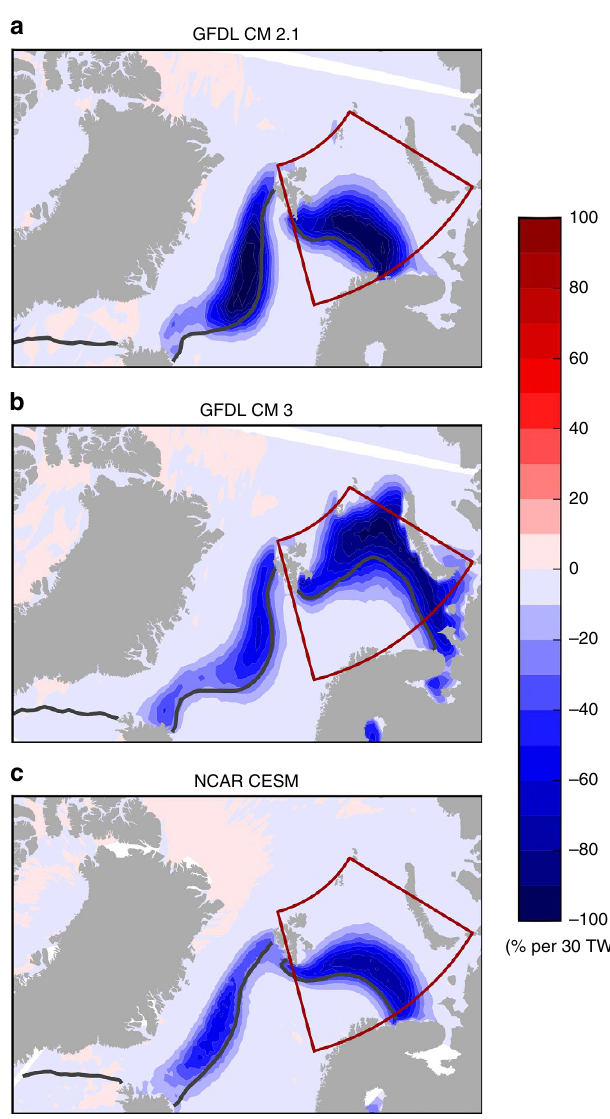
Figure 5 | Regression of 37-year March SIC trends on 37-year HT BSO trends in three long control simulations. ( a ) GFDL CM2.1 ( b ) GFDL CM3 ( c ) NCAR CESM. Red boxes outline the Barents Sea region, and black lines denote the climatological March sea ice edge in each model. The regression maps are scaled to correspond to a positive trend of 30TW per 37 years in HT BSO . White gaps in the upper right corners of a , b are due to the polar projection of SIC simulated on tri-polar grids in GFDL